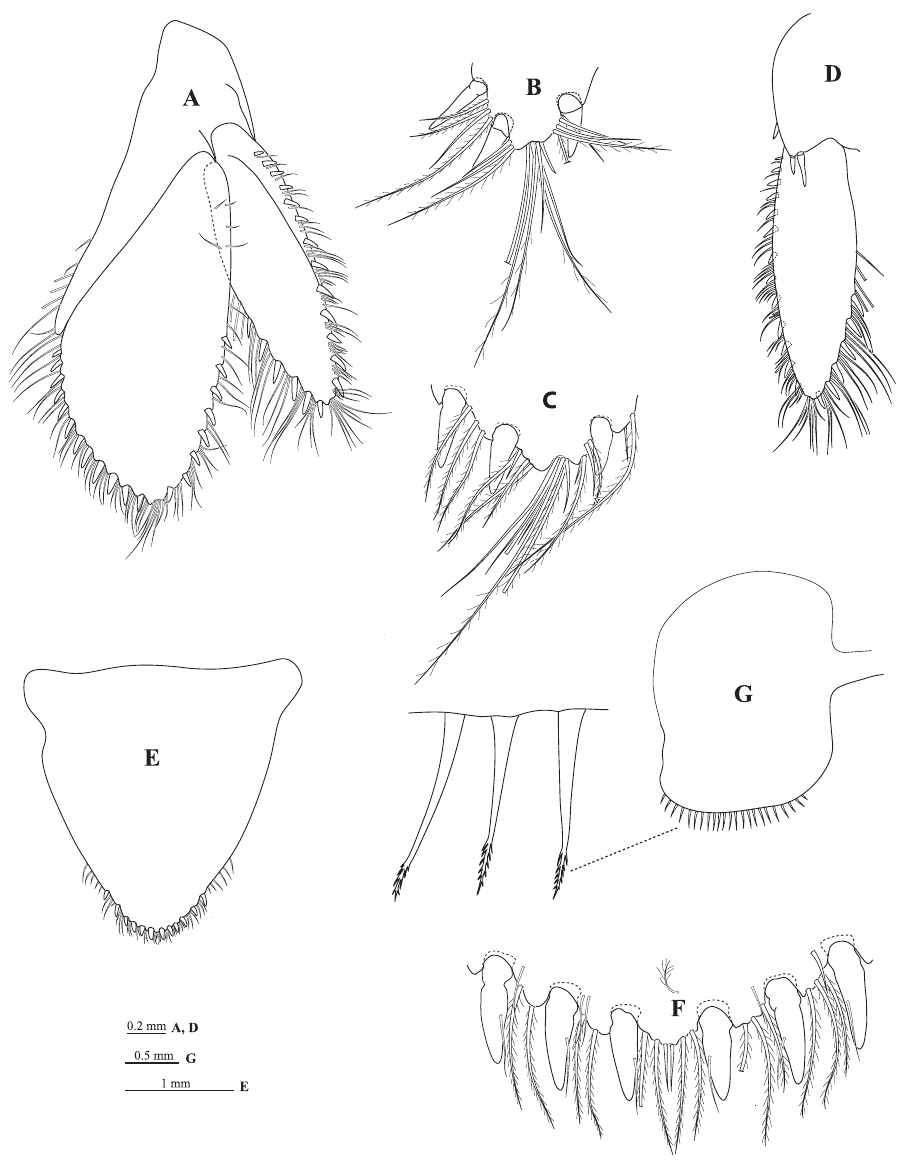
Figure 6. Cirolana songkhla sp. n., male paratype (PSUZC-CR0281-2) (11.2 mm) ( A–F ), ovigerous female (PSUZC-CR0281-2) (8.7 mm) ( G ). A uropod B uropod exopod apex C uropod endopod apex D uropod exopod e pleotelson F detail of pleotelson apex G oostegite 4.